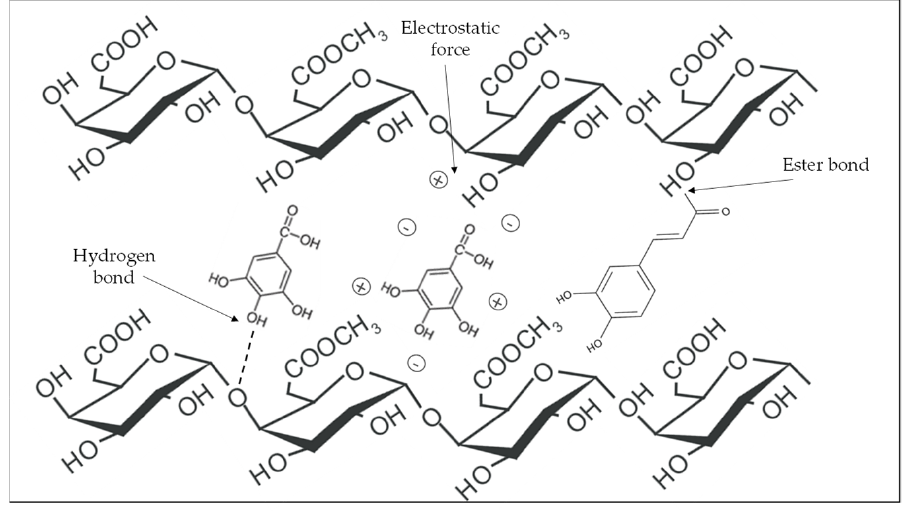
Figure 2. Physicochemical interactions between phenolic compounds and dietary fiber (pectin). A large percentage of polyphenols are associated with dietary fiber. According to the type of bonding and the nature of the phenolic compound, these polyphenols can be considered extractable and nonextractable (attached to the cell wall). During food digestion (gastric or small-intestine phase), some compounds are released. Those of higher molecular weight, such as tannins and proanthocyanidins, covalently bound to dietary fiber or proteins, can only be released under more drastic conditions such as hydrolysis with sulfuric acid or enzymatic action [58]. The amount of nonextractable polyphenols